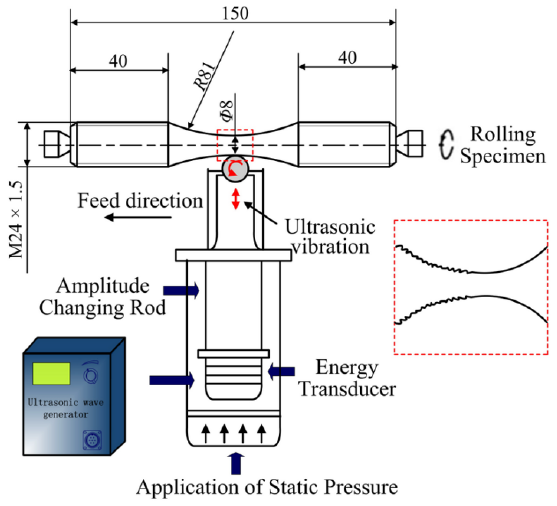
Figure 2. The hour glass fatigue specimen and high-frequency impacting and rolling (HFIR) schematic diagram.